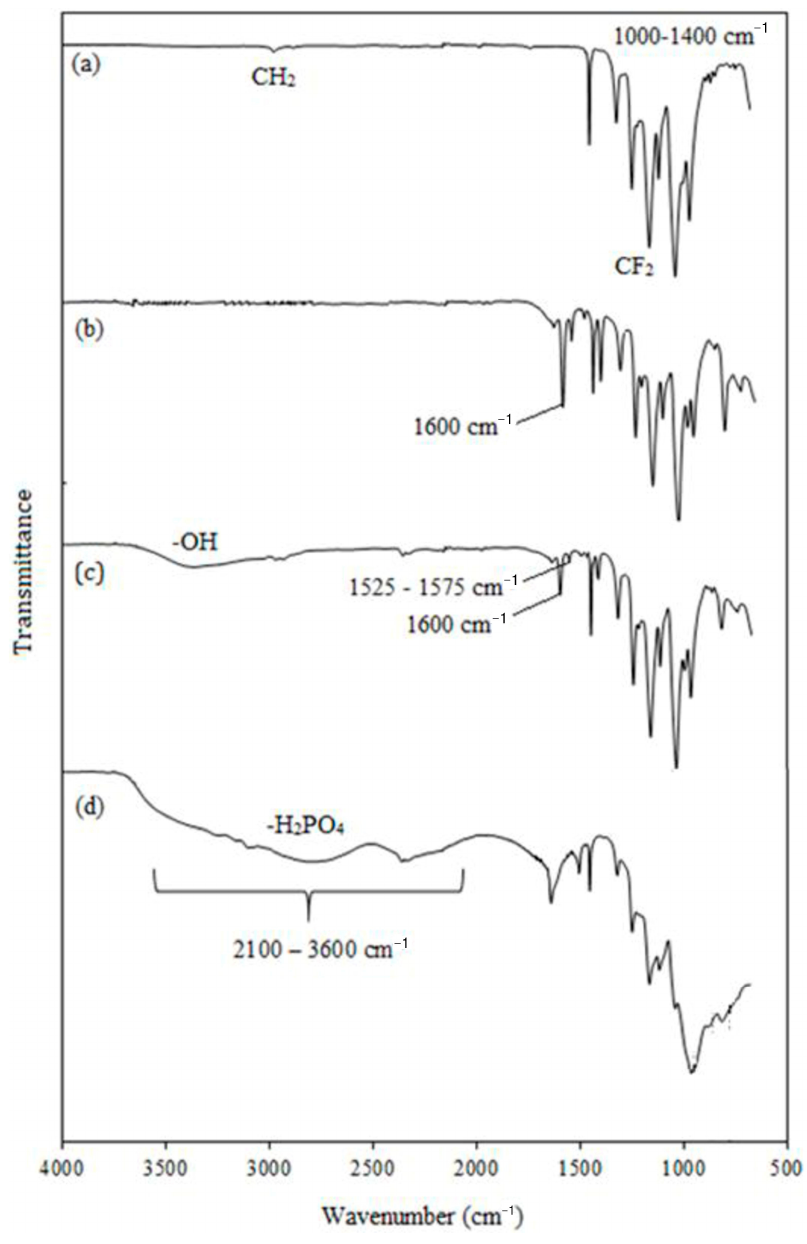
Figure 6. FTIR spectra of: ( a ) pristine ETFE film, ( b ) ETFE- g -P(4-VP) film, ( c ) ETFE- g -P(4-VP/1-VIm) film, and ( d ) ETFE- g -P(4-VP/1-VIm)/PA membrane with 59% DG .